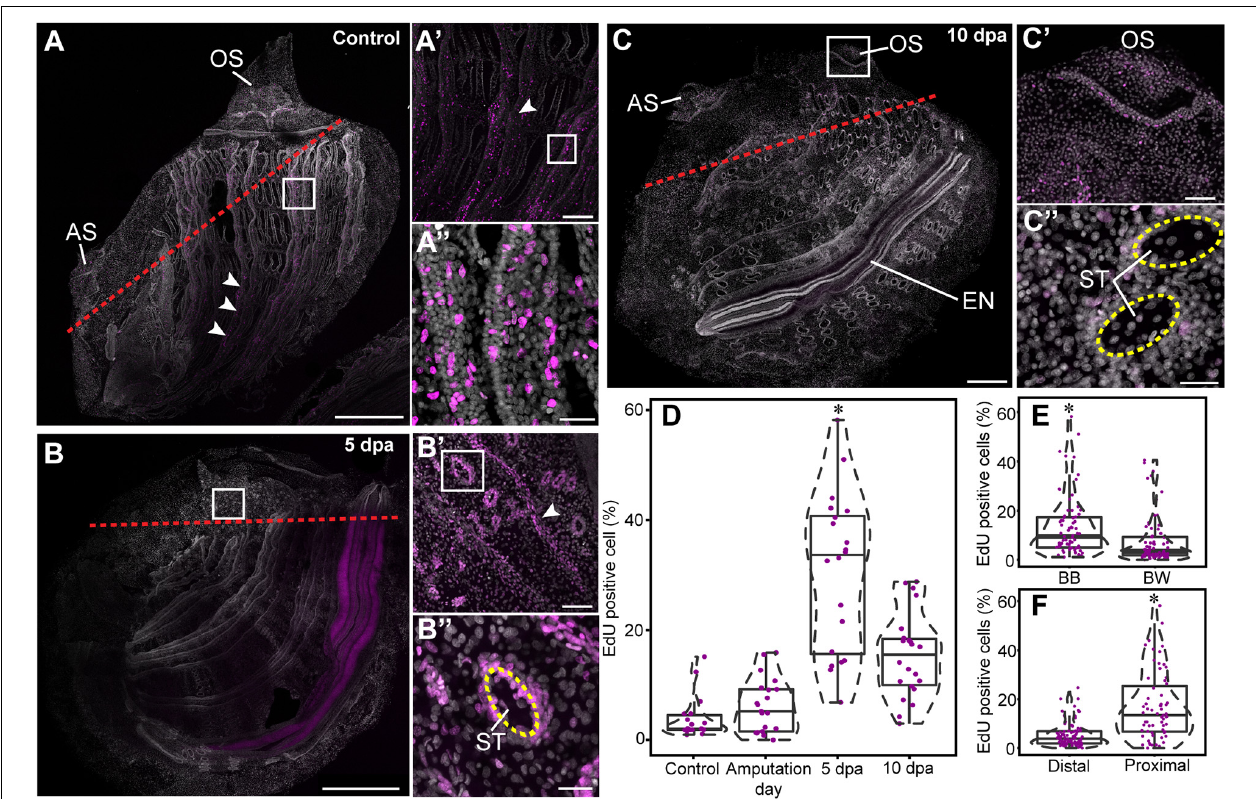
FIGURE 5 | Cell proliferation increase during anterior regeneration. Whole mount EdU staining images of anterior regeneration. EdU labeling in magenta and DAPI nuclear staining in gray. All panels are anterior to the top, right view. (A,A (cid:48) ,A (cid:48)(cid:48) ) Unamputated control. (A (cid:48) ) Branchial basket, enlargement of square area in (A) . (A (cid:48)(cid:48) ) Longitudinal vessels, enlargement of square area in (A (cid:48) ) . Red dashed lines outline the amputation line. White arrowheads indicate longitudinal vessels. (B,B (cid:48) ,B (cid:48)(cid:48) ) 5 dpa. (B (cid:48) ) Branchial basket, enlargement of square area in (B) . (B (cid:48)(cid:48) ) Stigma, enlargement of the square area in (B (cid:48) ) . Yellow dashed lines outline the stigma. (C,C (cid:48) ,C (cid:48)(cid:48) ) 10 dpa. (C (cid:48) ) Oral siphon, enlargement of square area in (C) . (C (cid:48)(cid:48) ) Stigmata. (D–F) Quantification of EdU-positive cells in 100 µ m 2 sections. Violin plots display the proportion (%) of EdU-positive cells in relation to total number of DAPI positive cell nuclei. The plot diameter reflects the probability density of EdU-positive cells for each time point. Jittered points overlaid on boxplots represent individual samples. The bottom and top of the boxes represent the first and third quartiles, the central band represents the median, and whiskers represent 1.5-fold the interquartile range. P -values calculated with the Mann Whitney Wilcoxon test are indicated above each boxplot. (D) Percentage of EdU-positive cells proximal to the amputation line along the different time points ( n = 3 per time point). (E) Percentage of EdU-positive cells ( n = 15) in the branchial basket (BB) and body wall (BW). (F) Percentage of EdU-positive cells ( n = 9) in proximal and distal areas from the amputation line. Atrial siphon (AS), endostyle (EN), oral siphon (OS), and stigmata (ST). Scale bar: (A,B) 500 µ m; 200; (A’,C) 100 µ m; (B (cid:48) ,C (cid:48) ) 50 µ m; (A (cid:48)(cid:48) ,B (cid:48)(cid:48) ,C (cid:48)(cid:48) ) 20 µ m (see also Supplementary Figure 4